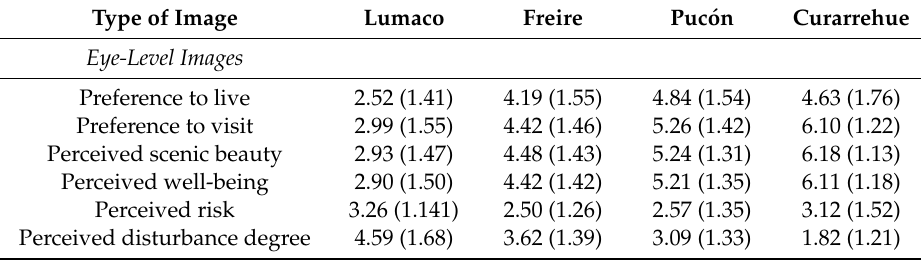
Table A1. Mean score and standard deviation (in brackets) of preferences and perceptions valued